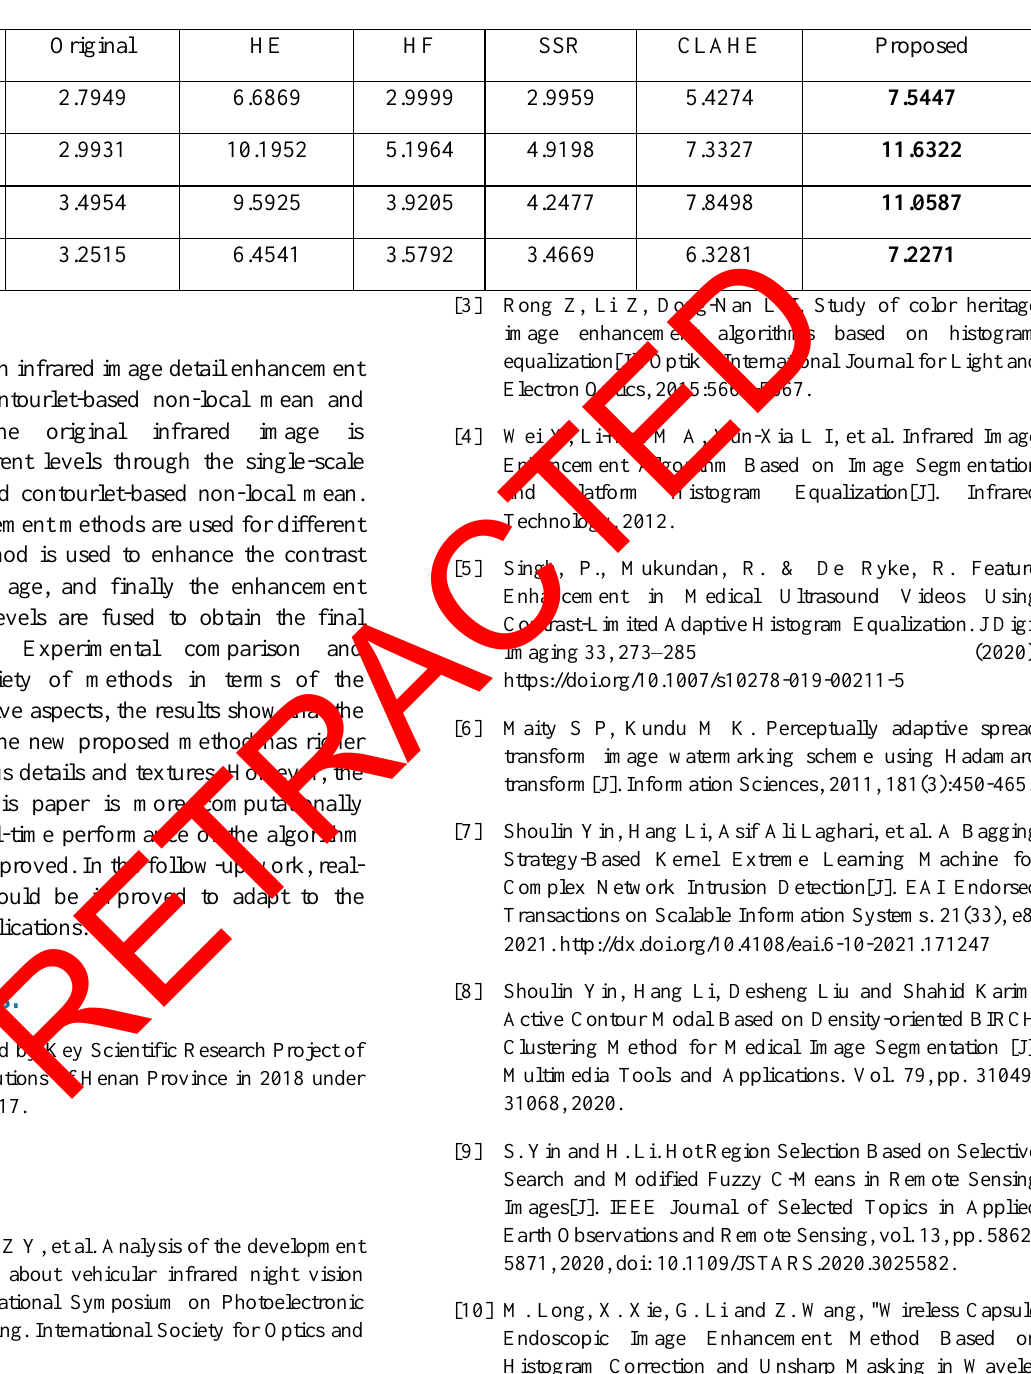
Table 2. AVG results with different